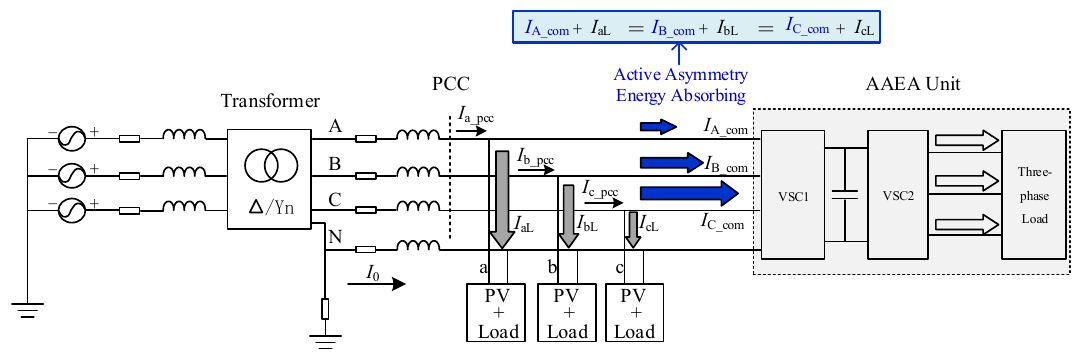
Figure 3. The schematic diagram of the three-phase imbalanced mitigation by the AAEA unit. The load with the expected additional function of “AAEA” is labelled as “AAEA Unit”. The AAEA Units are the three-phase consumers with back-to-back converters in the LVDN, such as three-phase air-conditioned buildings, freezing plants, and smelters;